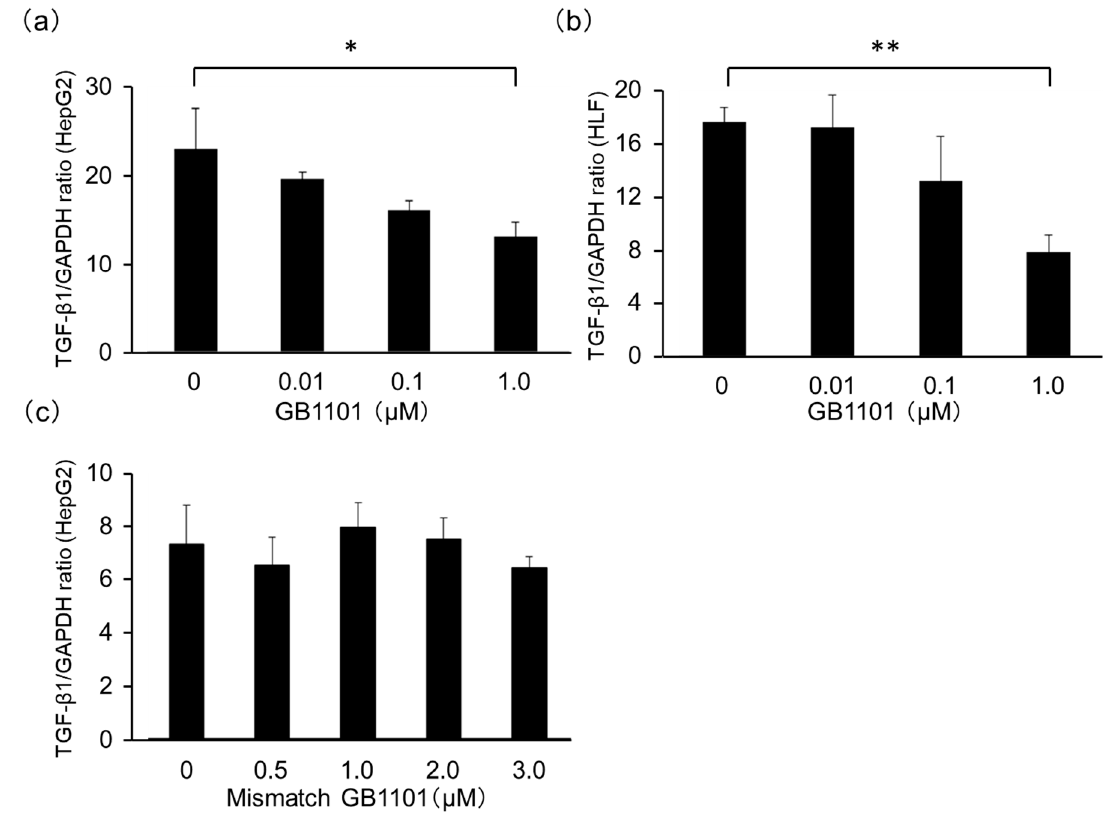
Figure 1. E ff ect of GB1101 and a mismatch pyrrole-imidazole (PI) polyamide on TGF- β 1 mRNA expression in liver cancer cells. Human hepatoblastoma cell line HepG2 and HLF were cultured in the absence or presence of 0.01 to 1 µ M GB1101 ( a , b ) or 0.5 to 5 µ M mismatch polyamide ( c ) for 48 h. Total RNA was extracted to assess the level of transforming growth factor ( TGF)- β 1 mRNA by real-time qPCR. Data are presented as the mean ± SD (n = 3). *, p < 0.05, **, p < 0.01.